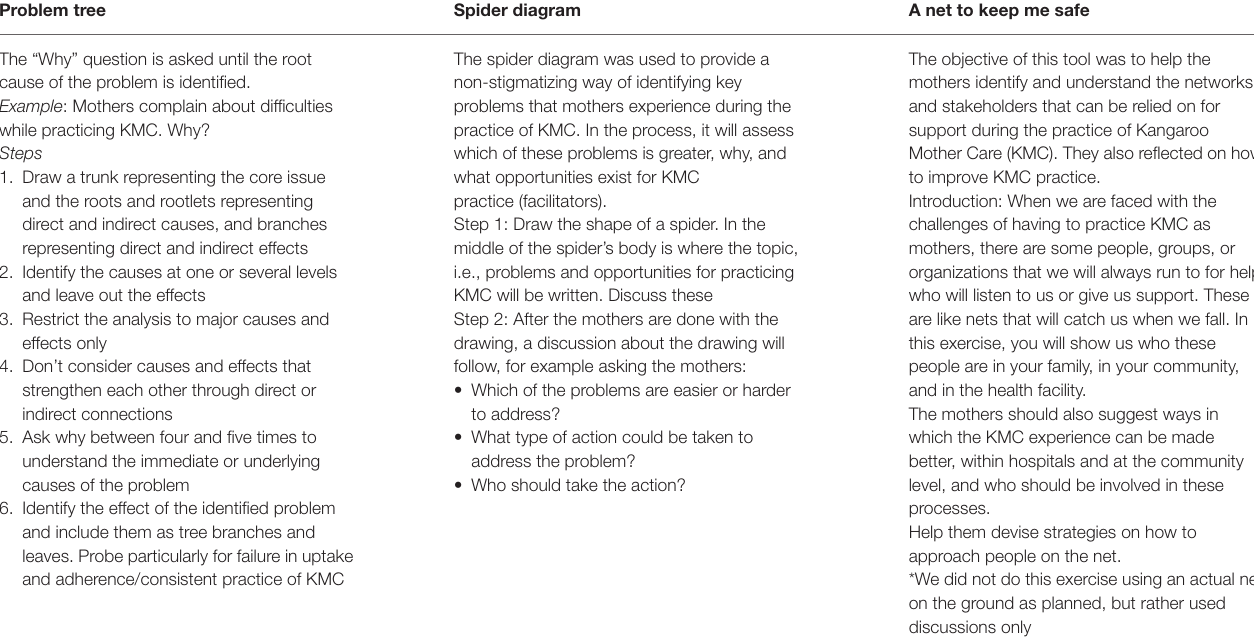
TABLE 1 | Group discussion approaches. Problem tree Spider